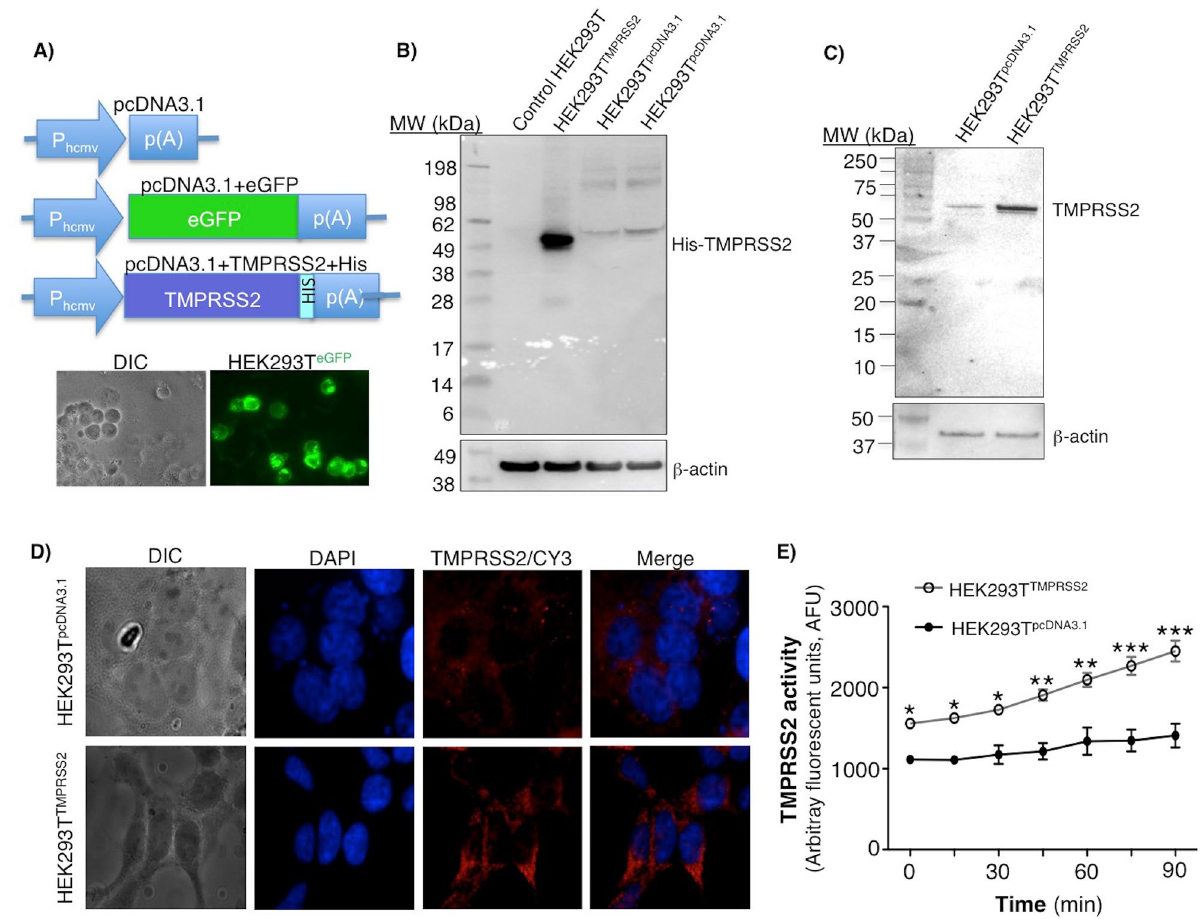
Figure 1. Overexpression of recombinant TMPRSS2 in HEK293T cells. ( A ) pcDNA3.1 empty vector, pcDNA3.1 eGFP , or pcDNA3.1 TMPRSS2+His plasmids (top panel) used to transfect HEK293T cells. Photomicrograph of pcDNA3.1 eGFP transfected cells (HEK293T eGFP ) (bottom panel). Cell lysates were prepared and immunoblotted with ( B ) anti-His antibody or ( C ) anti-TMPRSS2 antibody. ( D ) Immunocytochemistry staining to detect TMPRSS2 in control (HEK293T pcDNA3.1 ) and TMPRSS2–transfected HEK293T (HEK293T TMPRSS2 ) cells. ( E ) Spontaneous TMPRSS2 activity using the fluorogenic substrate Boc-QAR-AMC as a function of time in the HEK293T pcDNA3.1 and HEK293T TMPRSS2 cells. Data shown are representative or triplicate means ± SEM of three independent experiments. *p < 0.05, **p < 0.01, ***p < 0.001 compared to HEK293T pcDNA3.1